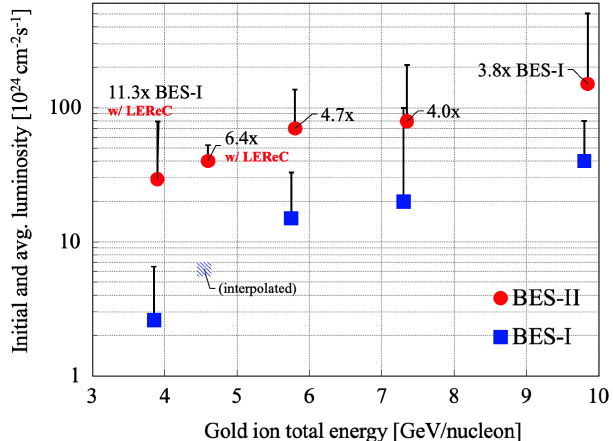
FIG. 1. The initial and average luminosities at five gold beam energies achieved during BES-I and BES-II. Red dots and blue squares represent the average luminosity. A small horizontal bar marks the initial luminosity. The average luminosity at 4 . 59 GeV = nucleon during BES-I is interpolated based on data collected at 3.85 and 5 . 75 GeV = nucleon.